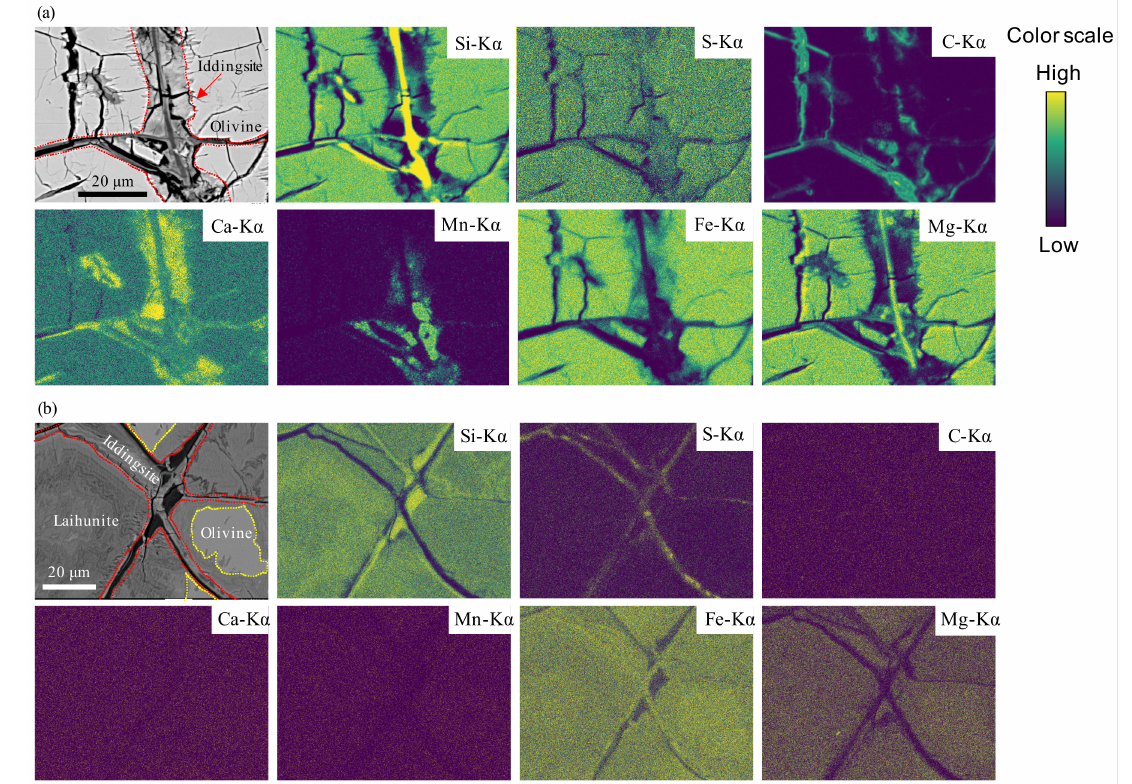
Figure 2. Backscattered electron (upper left) and elemental distribution images of iddingsite obtained via field-emission scanning electron microscope-energy-dispersive spectroscopy (FE-SEM-EDS). Iddingsite occurs inside the red line in the BSE image. ( a ) Representative images of carbonate-bearing iddingsite in Y 000593. The central part of the iddingsite is rich in Mg and Si, suggesting the presence of clay minerals. S could not be detected through SEM-EDS because its low concentration was below the detection limit. C was present throughout the iddingsite; the localized area of very high intensity is an effect of the resin used in the preparation of the thin section. Ca was also almost uniformly present throughout the iddingsite, and Mn was concentrated locally. Fe was present throughout the iddingsite, although its intensity was relatively weak owing to the effect of Fe in the olivine. ( b ) Representative images of sulfate-bearing iddingsite in Y 000593. The area within the yellow dotted line is pure olivine, and the area between the yellow and red dotted lines is laihunite. In the BSE image, the Si-rich vein appears to be darker than that in ( a ) because the contrast was adjusted to enhance the laihunite visibility. These images were obtained from the polished tip sample (Y 000593,